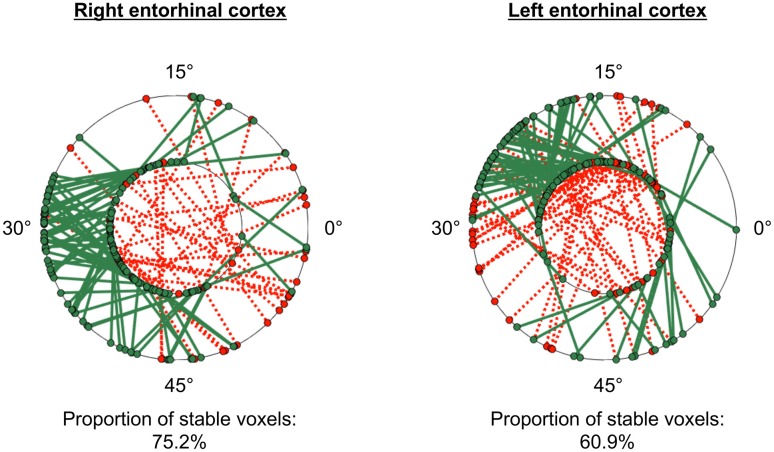
GridCAT polar plots showing coherence of the grid orientation within voxels, across runs 1 and 2, in right and left entorhinal cortex ROIs. In both the right and left entorhinal cortex, the majority of voxels maintained the same grid orientation (±15°) across the two runs; the proportion of voxels maintaining the same orientation across runs is calculated automatically for the user. The two black rings in each plot represent the two different runs (inner ring: run 1, outer ring: run 2), and the orientation of the grid code for each voxel is indicated with a circular marker; a line connects the orientations of each voxel. Green solid lines indicate voxels with stable orientations, whereas red dotted lines indicate voxels with unstable orientations. The GridCAT allows the user also to customize the plots, including the color schemes, line styles, as well as adapting the threshold for classifying a voxel as stable.